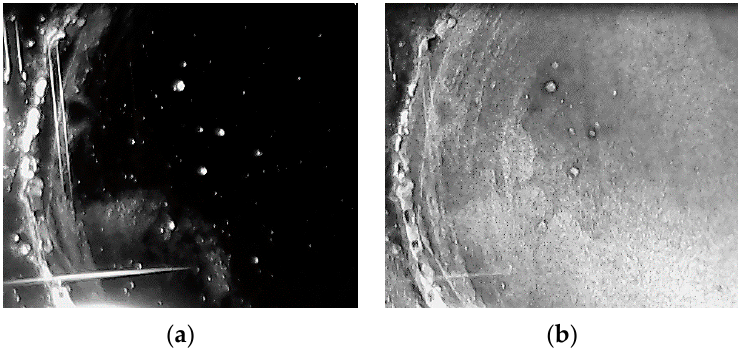
Figure 4. TiO 2 coating on SiO 2 substrate at room condition ( a ) and exposed to 90% humidity ( b ).